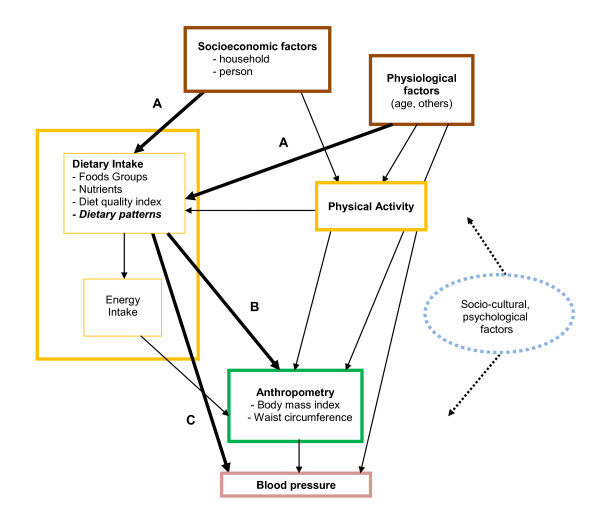
Conceptual framework for analysis of associations between dietary patterns, socio-economic factors and health outcomes. Arrows A, B and C (solid bold lines) represent the main associations studied, while the other associations represented (solid thin lines) were taken into account only to adjust for possible confounding; socio-cultural and psychological factors where not directly measured nor analysed in the study but represented so as to keep in mind that they may interact (dashed arrows) with the other factors at the different levels of the conceptual framework.